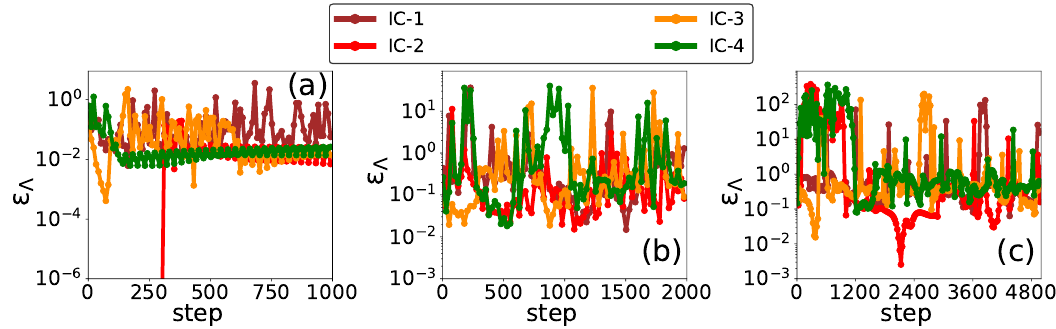
= 1.2 using different initial conditions (IC): a Figure 3: The evolution of ε Λ at J y random number state (“IC-1”, brown line), an empty state with all spins pointing ‘down’ (“IC-2”, red line), a full state with all spins pointing ‘up’ (“IC-3”, orange line), and a state where each spin has components 〈 σ x 〉 = 1, 〈 σ y 〉 = 1, 〈 σ z 〉 = − 1 (“IC-4”, green line), for timesteps (a) δ t = 10 − 1 , (b) δ t = 10 − 2 , (c) δ t = 10 − 3 . All other parameters are the same as in Fig. 1. Energies given in units of κ = 1.